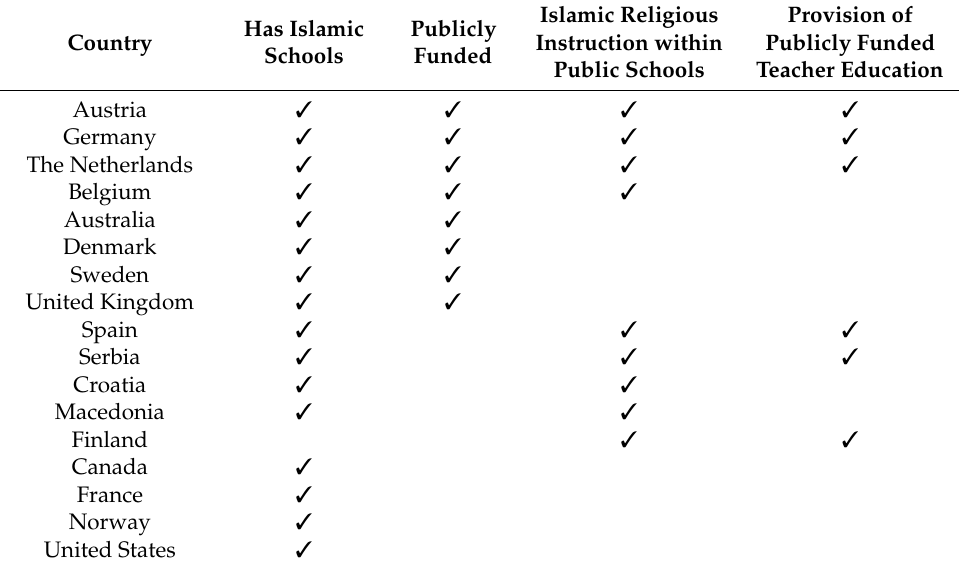
Table 3. Summary of Islamic schooling in the cultural